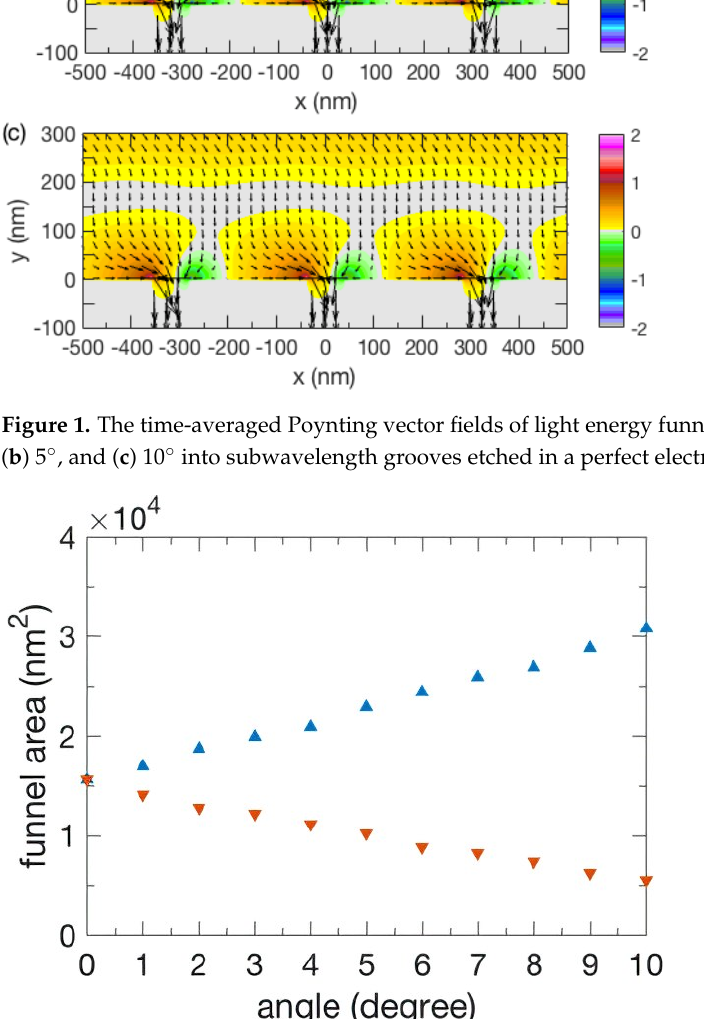
Figure 2. The relationship between funnel area and the angle of incidence. The left (right) funnel area is indicated by the blue upward-triangle (orange downward-triangle).